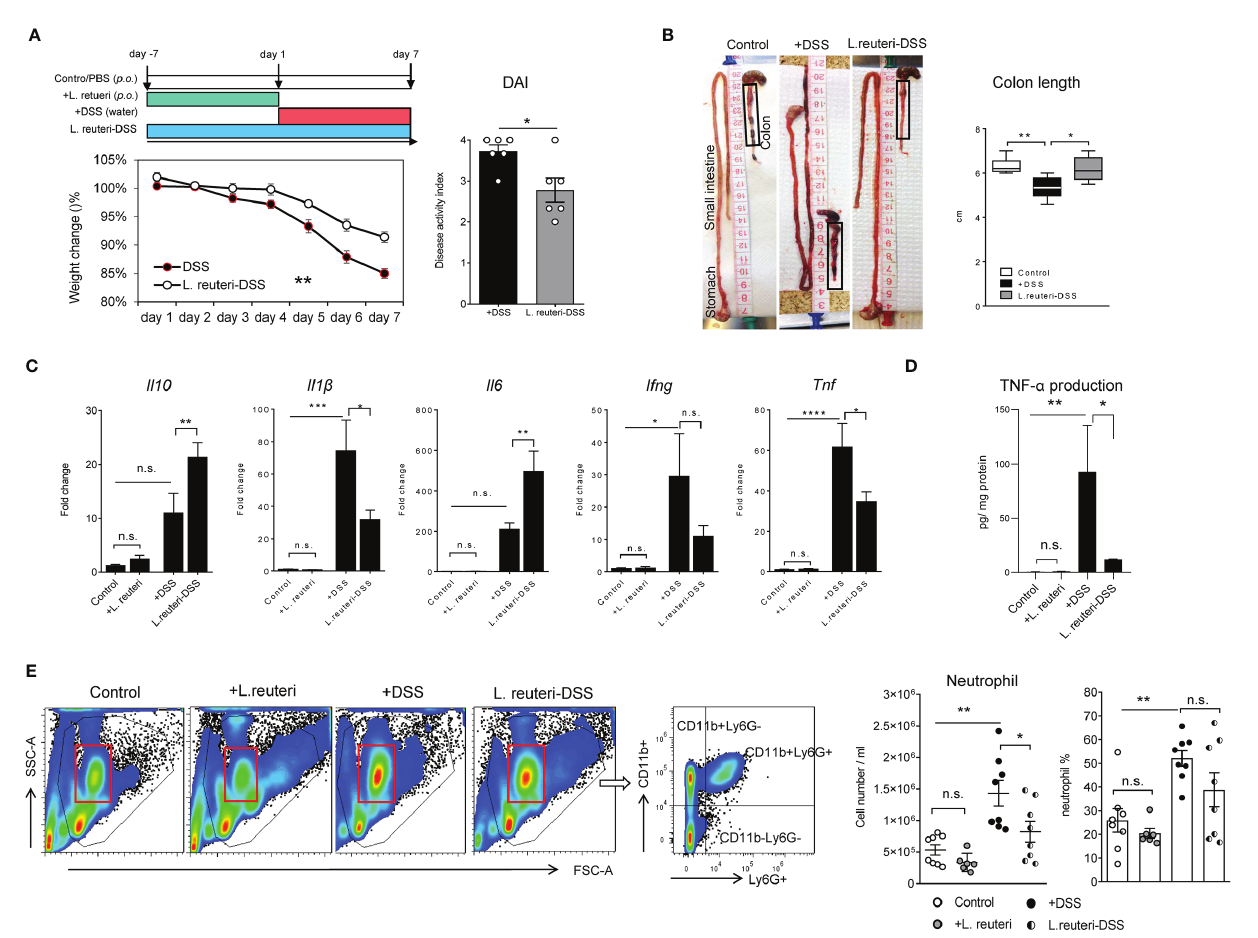
FIGURE 1 | Peroral treatment with Limosilactobacillus reuteri reduces in fl ammatory responses in DSS-induced colitis in young mice. (A) Wild-type mice were administered 3% DSS in drinking water for 7 consecutive days (red band); L. reuteri ATCC PTA 4659 (10 8 CFU) was given daily for 7 days (green band) or 14 days starting 7 days prior to DSS treatment ( L. reuteri -DSS, blue band) as illustrated. Body weight was recorded daily, and disease activity index (DAI) was calculated. (B) Representative images show changes of intestinal morphology and colon length (cm). (C) q-RT-PCR analysis of gene expression of cytokines (fold change) and (D) TNF- a production (pg/mg protein). (E) Flow cytometry analysis of neutrophil (live CD11b + Ly6G + ) responses in blood. Data are presented as mean ± SEM (n = 6 – 8 mice per group). * p < 0.05, ** p < 0.01, *** p < 0.001, **** p < 0.0001 using two-tailed Student ’ s t test and ANOVA with Tukey ’ s post-hoc test. DSS, dextran sulfate sodium. ns, non signi fi